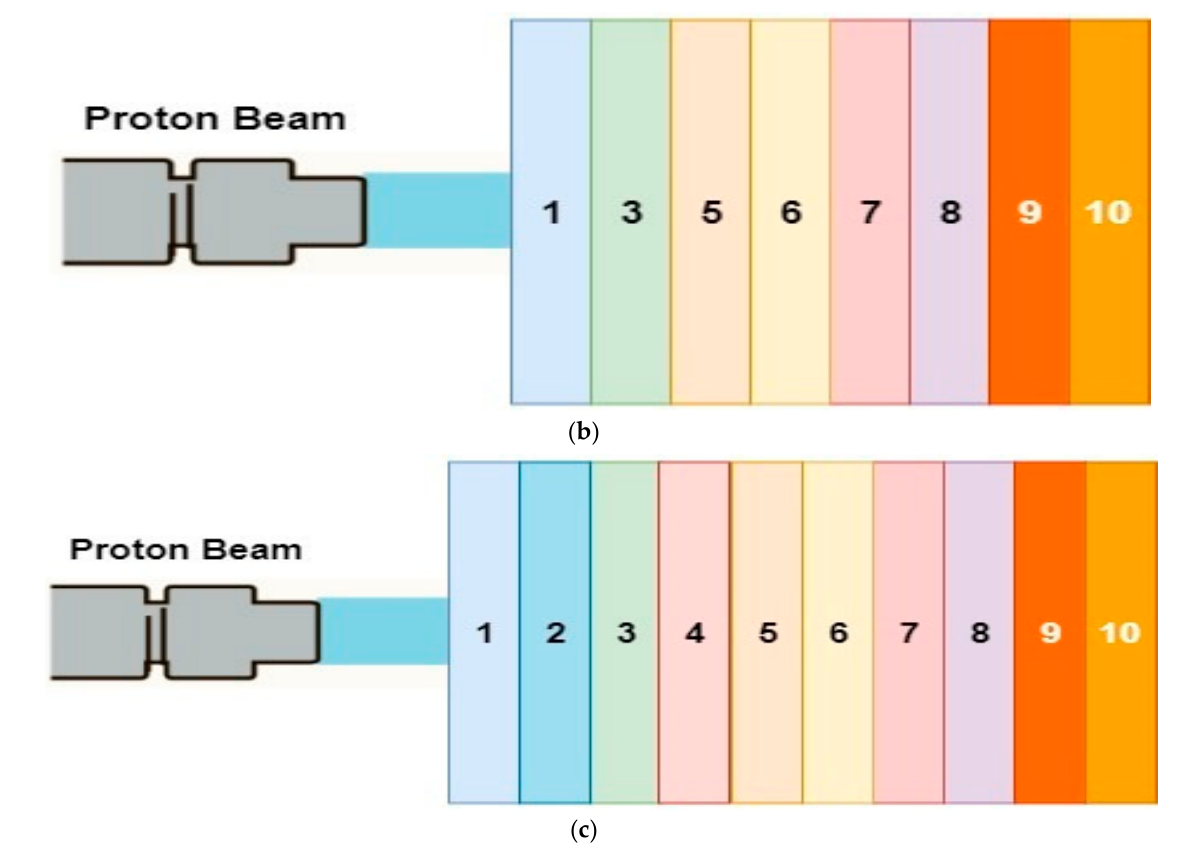
Figure 1. ( a ) A cross-sectional view of the focused mouth area ( b ) Mandibular region tooth plate premolar phantom section ( c ) Molar phantom section of mandibular region tooth plate. Layers (1–10) are explained in detail in Table 1. Table 1. Atomic percentage, atomic density and density of the biological layers forming from the mandible [32]. Atomic Density (10 22 Biomaterial Chemical Composition (%) Density (g/cm 3 atom/cm 3 )